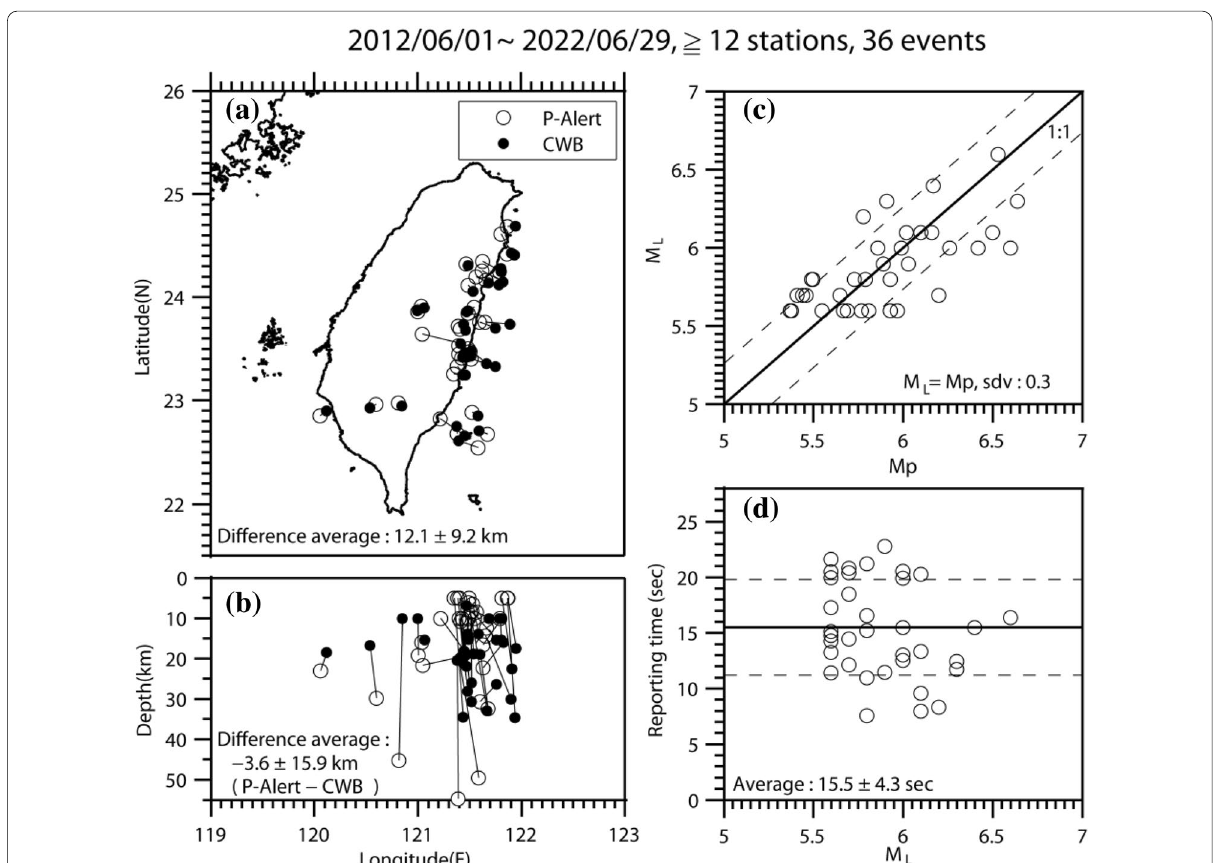
Fig. 4 Comparison of earthquake information ( a – c ) given by the P‑Alert system and the CWB earthquake catalogs. d Reporting times of the P‑Alert